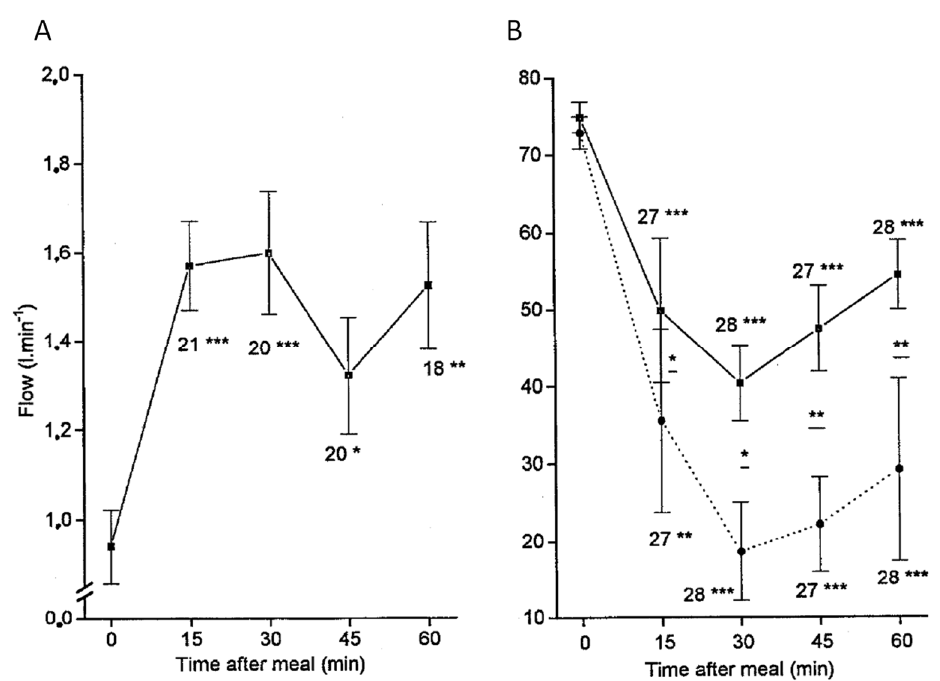
Figure 2. ( A ) Portal flow and ( B ) arterial to portal blood velocity ratio, both monitored by Doppler ultrasonography after ingestion of a standard liquid meal of 500 kcal. In ( B ), full and dashed curves correspond to left and right hepatic arteries, respectively. The number of observations and p for the student t -test for each measurement against the baseline appear under the error bars: * p < 0.05; ** p < 0.005; *** p < 0.0005. (reprinted from [18] with authorization of Springer Nature).